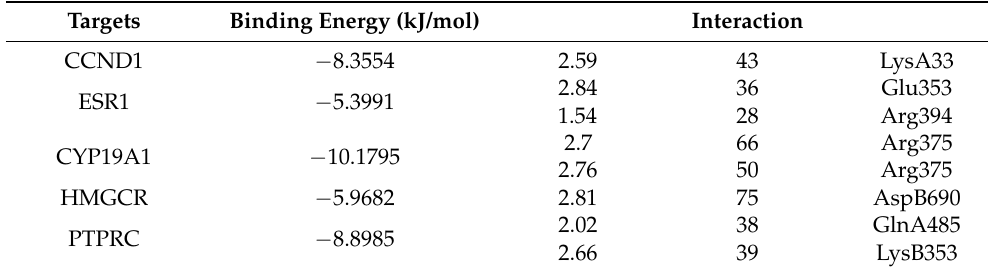
Figure 6. 3D and 2D images of best docked results A purple dotted line depicts metal or ion interaction, and a green dotted line depicts side-chain proton acceptor/donors. Basic and acidic amino acids are represented by blue and red circles, respectively. Certain amino acids have a blue backdrop because they have been exposed to solvents. Additionally, ligand atoms with blue coloring in front of them show solvent exposure. Table 4. Glutinol-target molecular docking